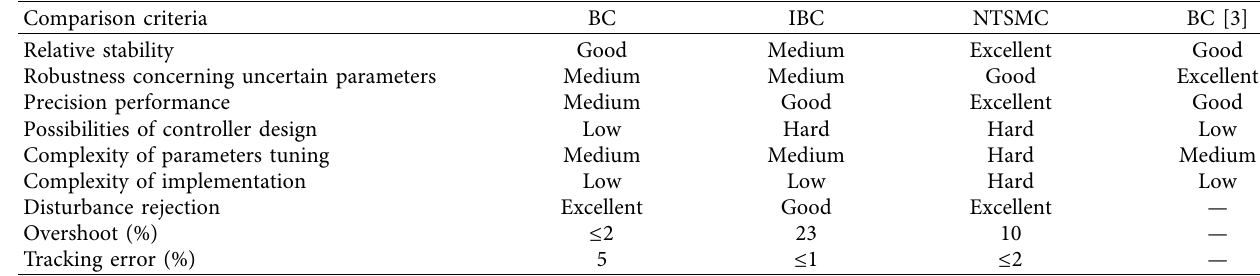
Table 2: Comparison